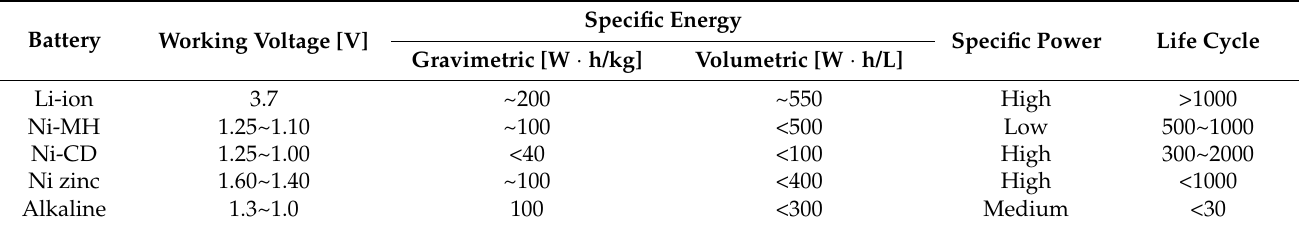
Table 2. Comparison of different types of batteries.